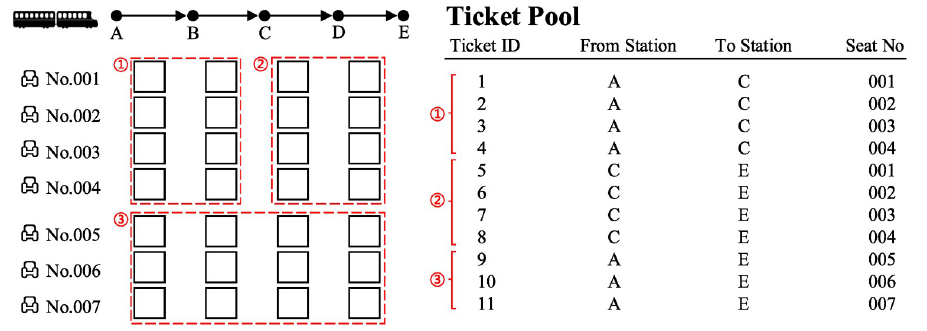
Fig 2. An example of partitioned booking limit